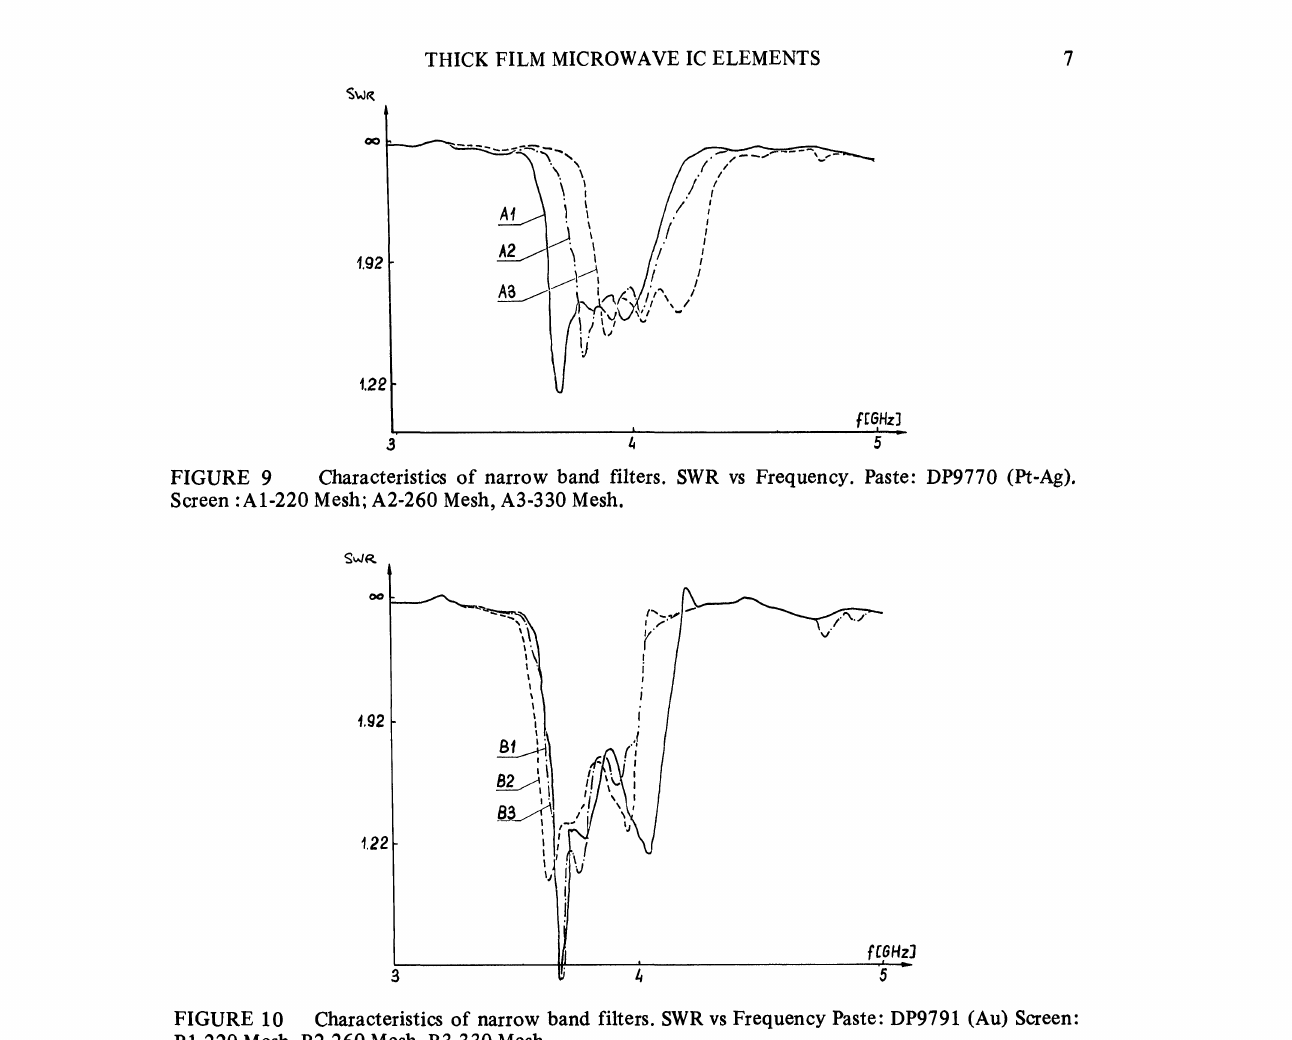
FIGURE 10 Characteristics of narrow band filters. SWR vs Frequency Paste: DP9791 (Au) Screen: B1-220 Mesh, B2-260 Mesh, B3-330 Mesh. TABLE II Basic parameters of the filters Fig.